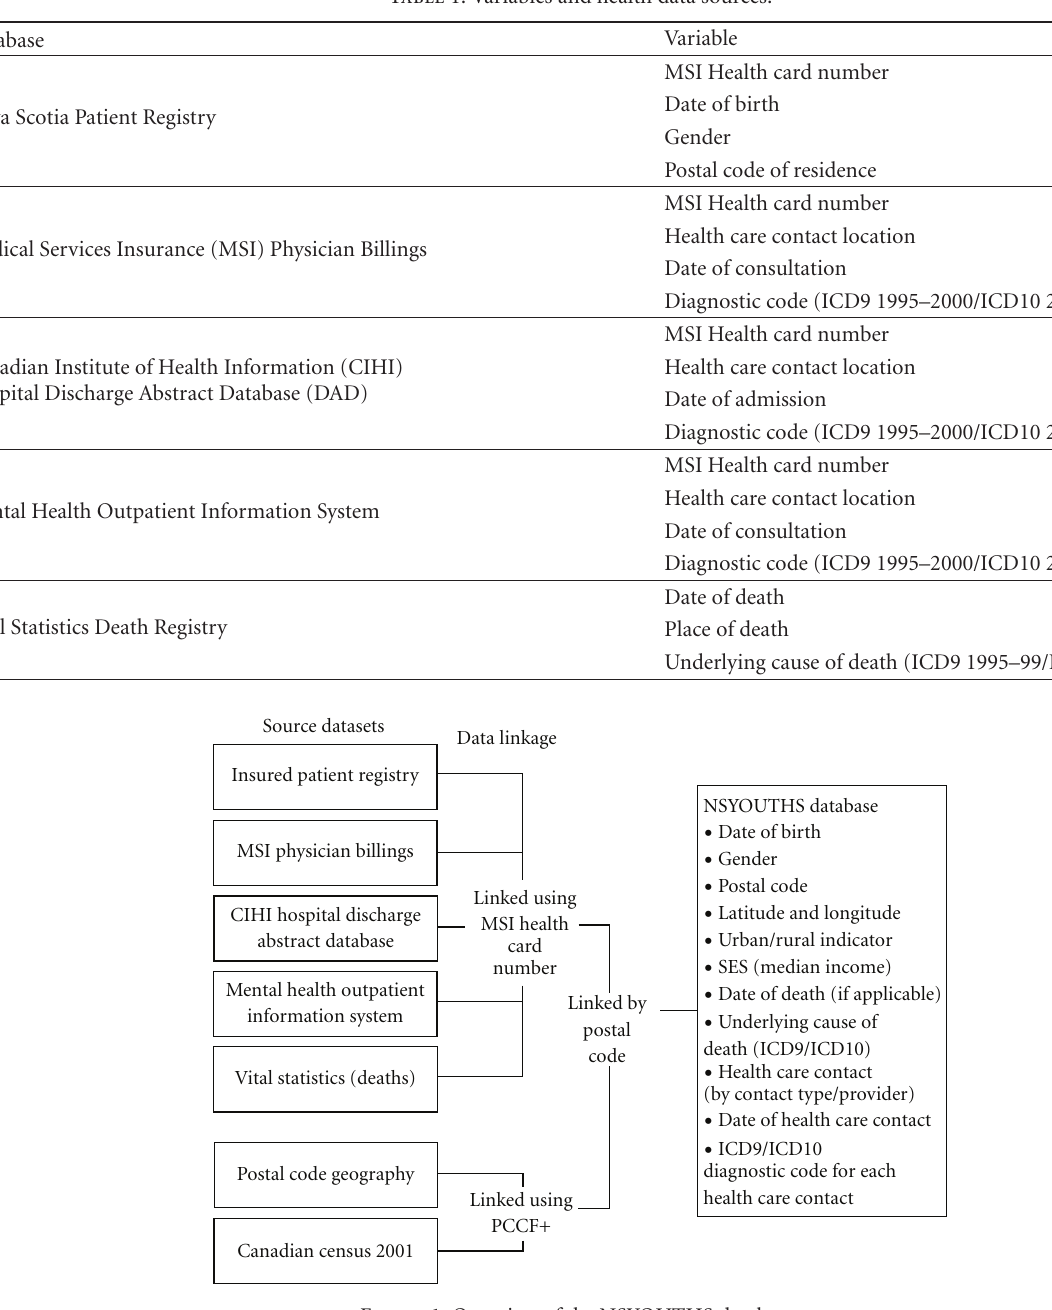
Figure 1: Overview of the NSYOUTHS